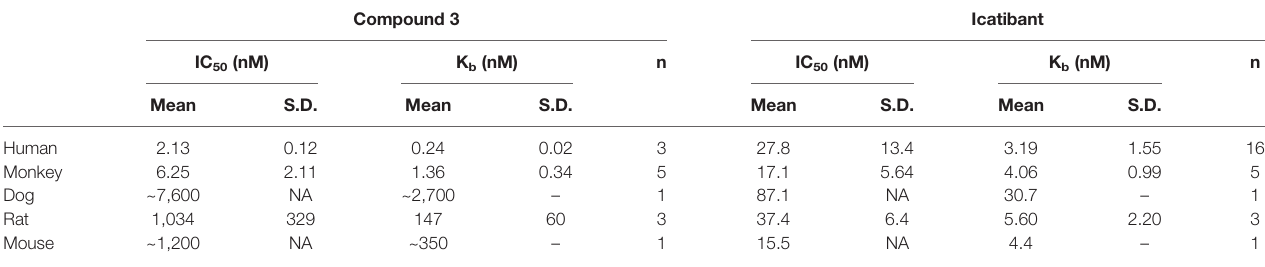
TABLE 3 | Antagonist potencies of Compound 3 and icatibant at the B 2 receptor from different species.